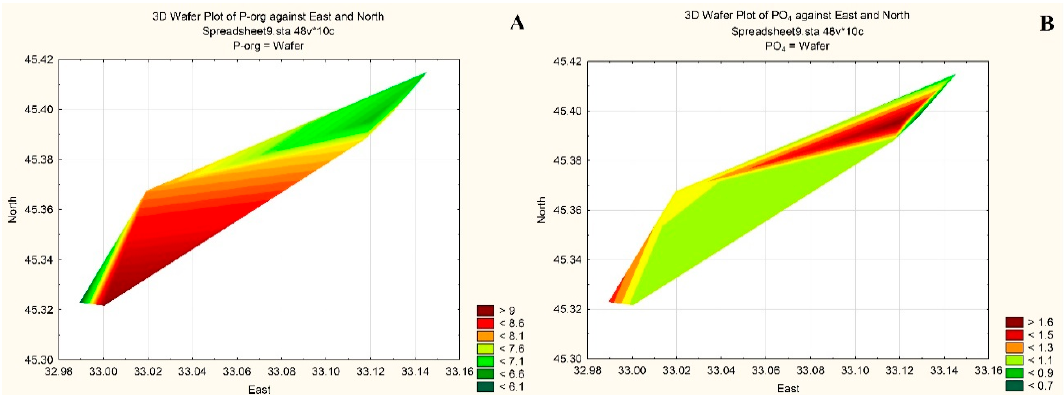
Figure 9. Dissolved organic phosphorus ( A ) and orthophosphate ( B ) concentrations in the water column at the sampling stations in the Donuzlav Gulf of the Black Sea.